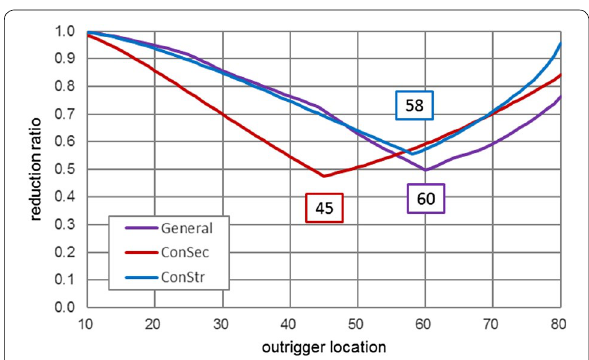
Fig. 4 Relation between location of the outrigger and reduction